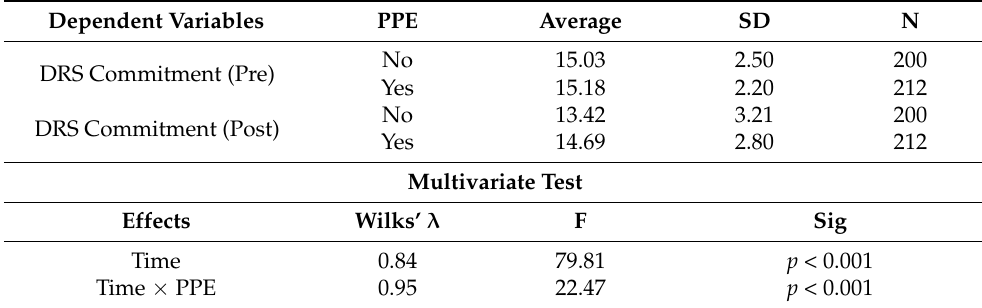
Table 10. Repeated measures ANOVA model of time (i.e., pre- and post-pandemic first-wave effect) and PPE effects on commitment hardiness.